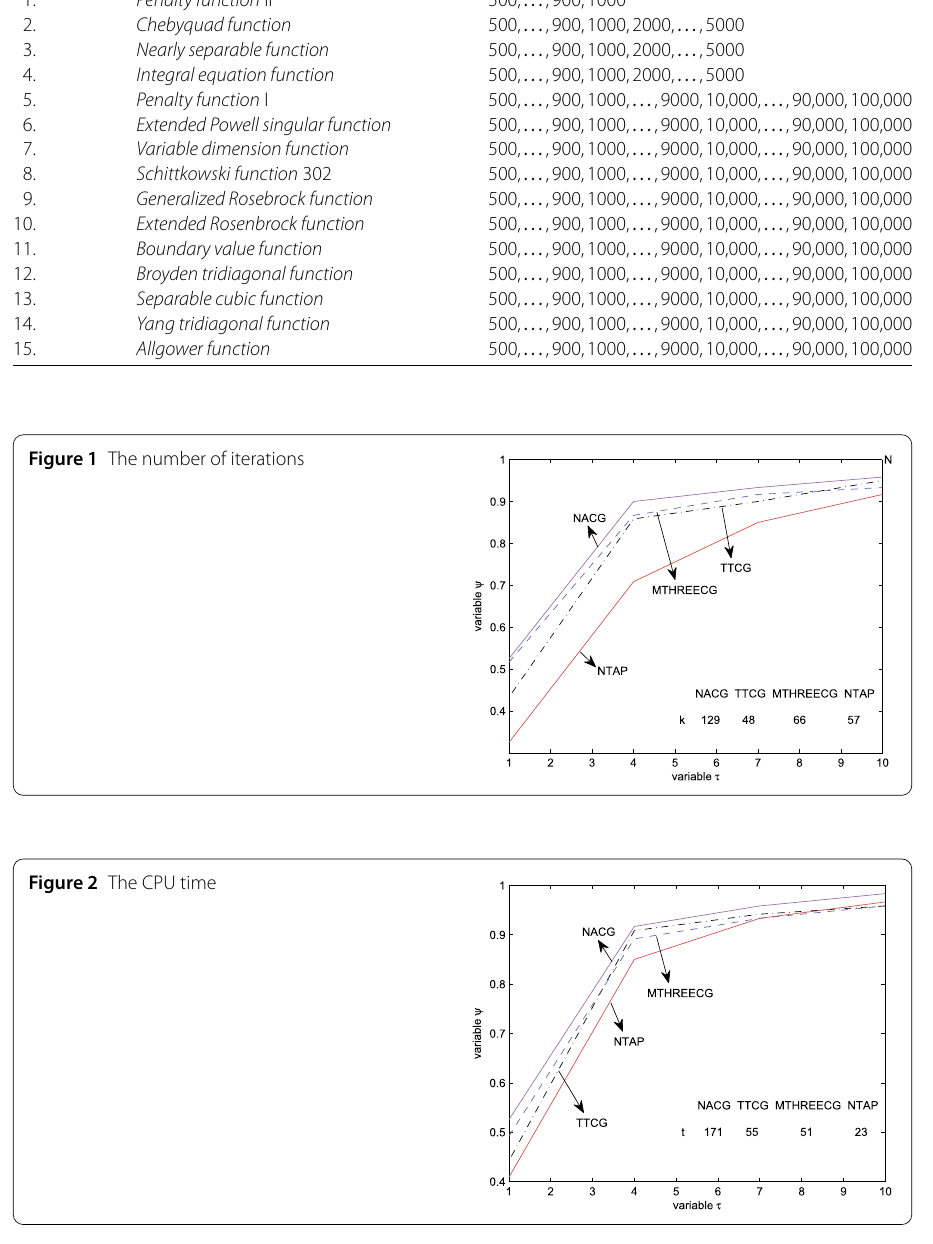
Table 1 The test problems and their dimensions